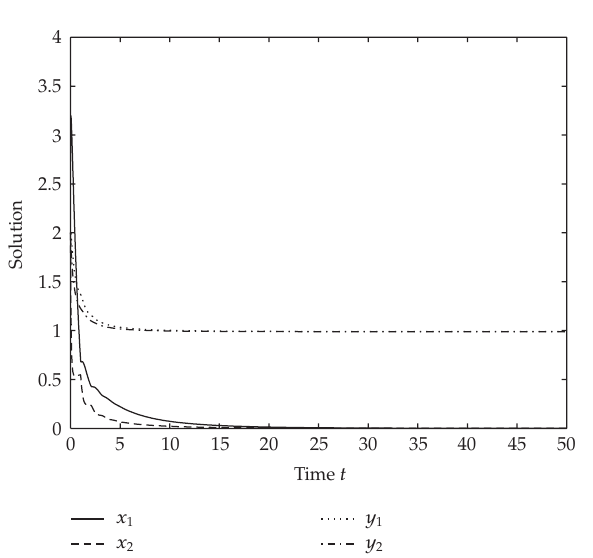
Figure 2: The temporal solution found by numerical integration of system (cid:3) 4.2 (cid:6) with (cid:3)Φ (cid:3) θ (cid:6) , Φ (cid:3) θ (cid:6) , Ψ (cid:3) θ (cid:6) , Ψ (cid:3) θ (cid:6)(cid:6) (cid:7) (cid:3) 5 (cid:3) 1 − e − 1 (cid:6) , 2 , 2 , 2 (cid:6) 1 2 1 2